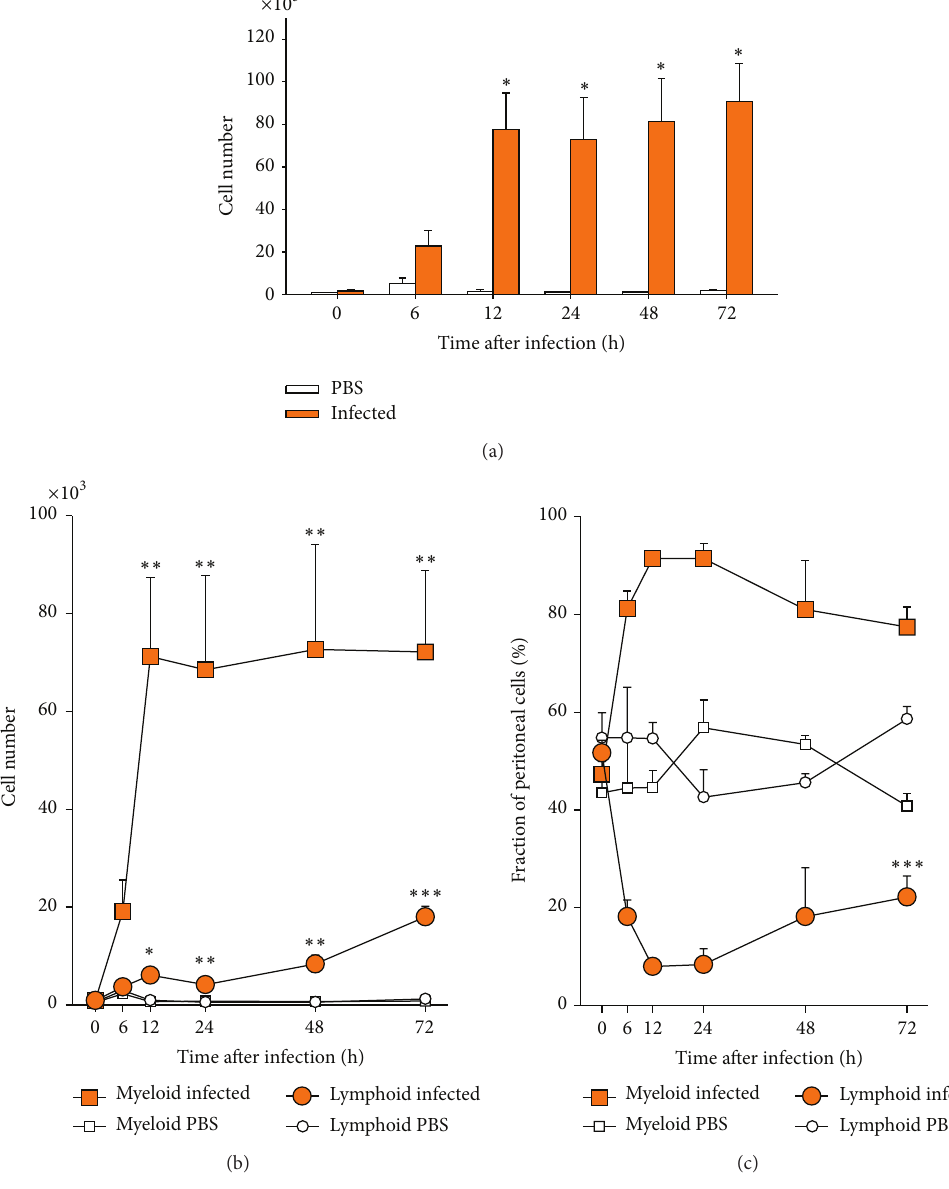
Figure 5: Kinetics of leukocyte recruitment into the peritoneum after infection with A. salmonicida . (a) The total number of leukocytes in the peritoneal fluid in infected trout (filled bars) and PBS-injected controls (open bars) was determined with flow cytometry and is given as mean ± SEM from five fish per time point (ordinate). (b) Differentiation of the number of recruited cells into myeloid cells (square symbols) and lymphocytes (circles). (c) Alteration of the percentage of myeloid cells (square symbols) and lymphocytes (circles) after PBS injection (open symbols) or infection with A. salmonicida (filled symbols) as calculated from the data given in (b). Asterisks denote statistical significance with 𝑝 < 0.001 ( ∗ ∗ ∗ ), 𝑝 < 0.01 ( ∗∗ ), and 𝑝 < 0.05 ( ∗ ), compared to controls (0 hpi), assessed with one-way ANOVA, followed by Tukey’s post hoc